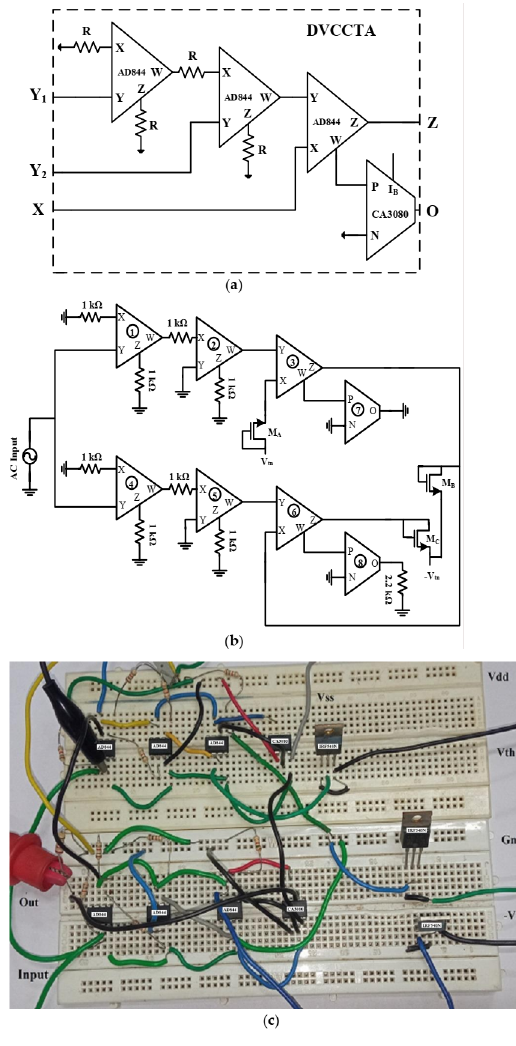
Figure 16. Macro model circuit ( a ) DVCCTA ( b ) Rectifier circuit ( c ) Breadboard implementation using commercial